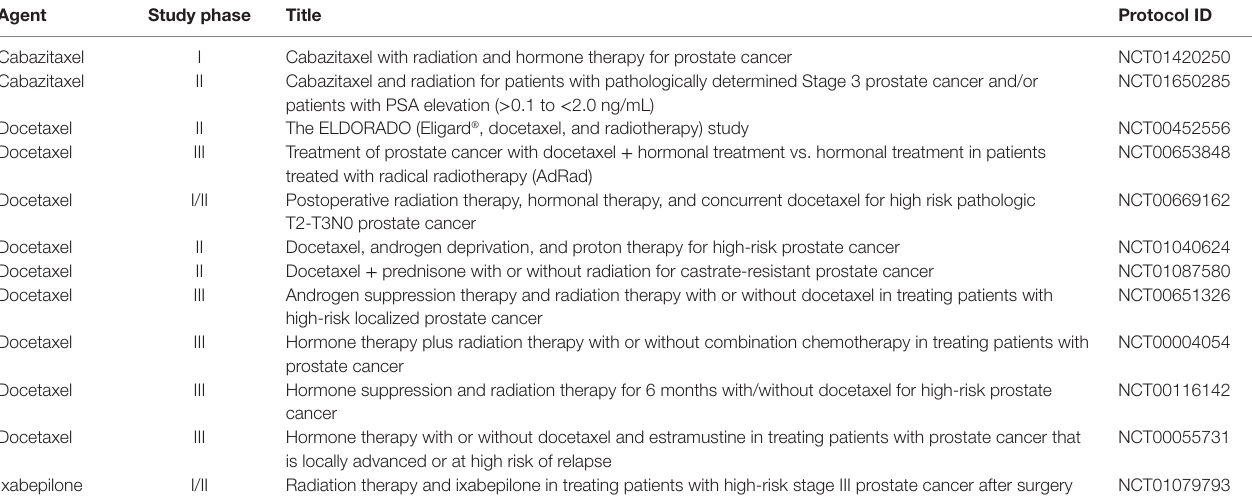
TABLe 2 | Ongoing clinical trials testing radiotherapy combined with chemotherapy in non-indolent, localized prostate